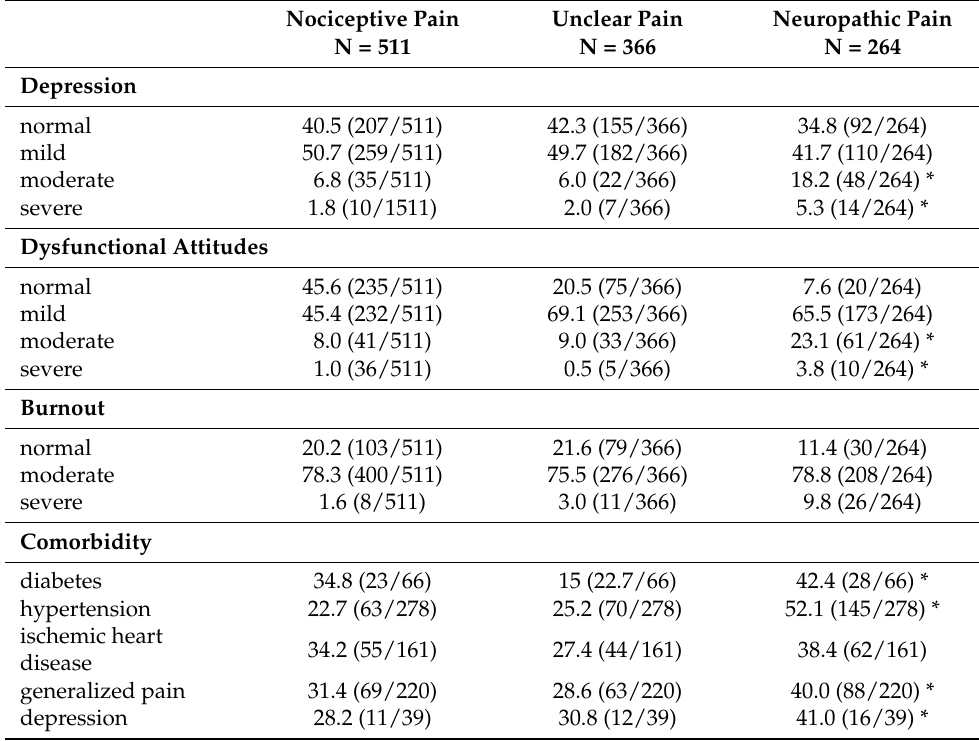
Table 4. Somatic and mental factors associated with neuropathic low back pain, * p <